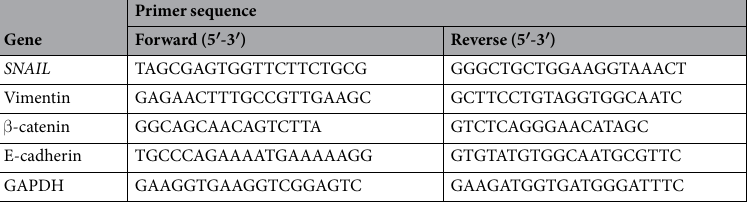
Table 2. Primers used for PCR